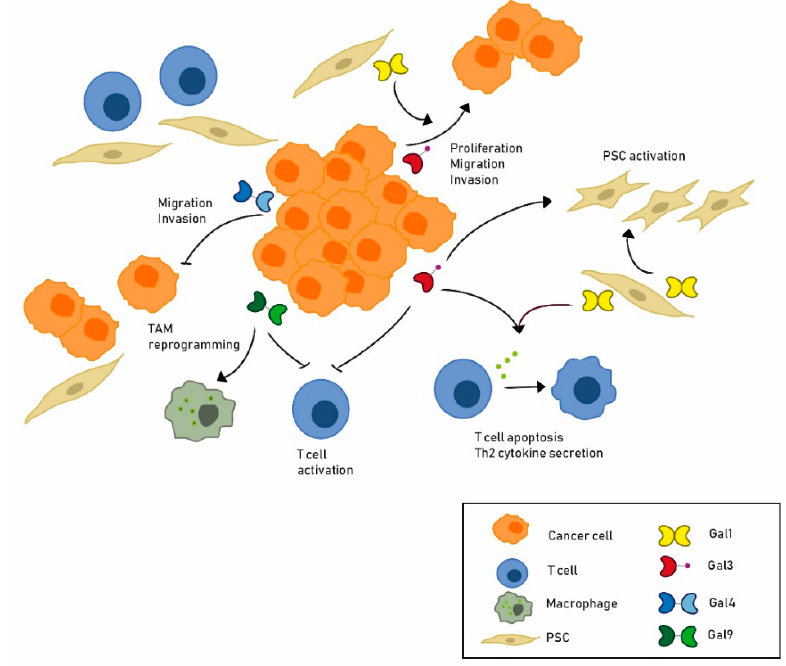
Figure 1. Expression and role of galectins in pancreatic cancer. The most important roles for Gal1, Gal3, Gal4, and Gal9 in pancreatic cancer are shown. Gal1, mainly expressed in pancreatic stellate cells (PSCs), has been reported to play an autocrine role in PSC activation as well as a paracrine role inducing tumor cell proliferation, invasion, migration, T-cell apoptosis, and Th2 cytokine secretion. Gal3, which is expressed in tumor epithelial cells, is associated to tumor cell migration, invasion, PSC activation, and immune response modulation. On the other hand, Gal4, expressed in tumor cells, inhibits tumor cell migration and invasion. Finally, Gal9 has been related to tumor-associated macrophage (TAM) reprogramming and inhibition of T-cell activation. Table 1. The expression of galectins and their main functions in pancreatic ductal adenocarcinoma (PDA).